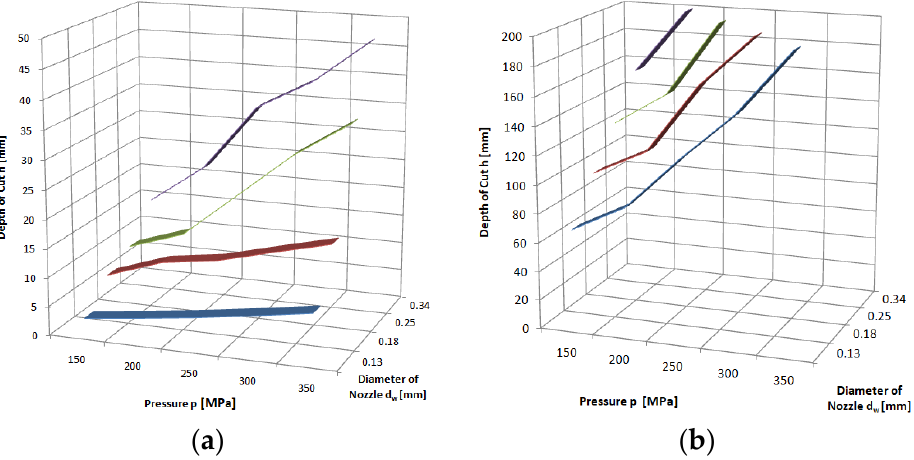
Figure 6. Influence of pressure and waterjet diameter on cutting depth of: ( a ) granite; ( b ) sandstone, with abrasive waterjet: feed speed v p = 3 mm·s − 1 , abrasive flow rate 𝑚(cid:4662) (cid:3028) = 6.7 g·s − 1 .